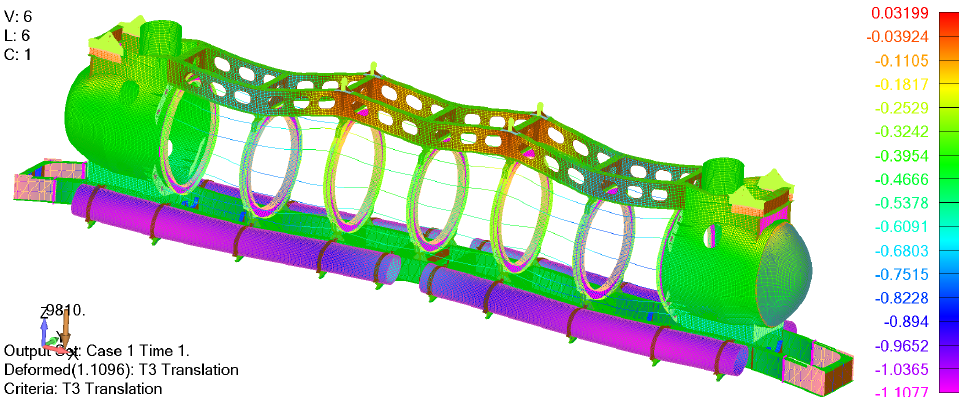
Figure 15. Vertical displacements (in mm) of the assembled structure for the lifting condition.